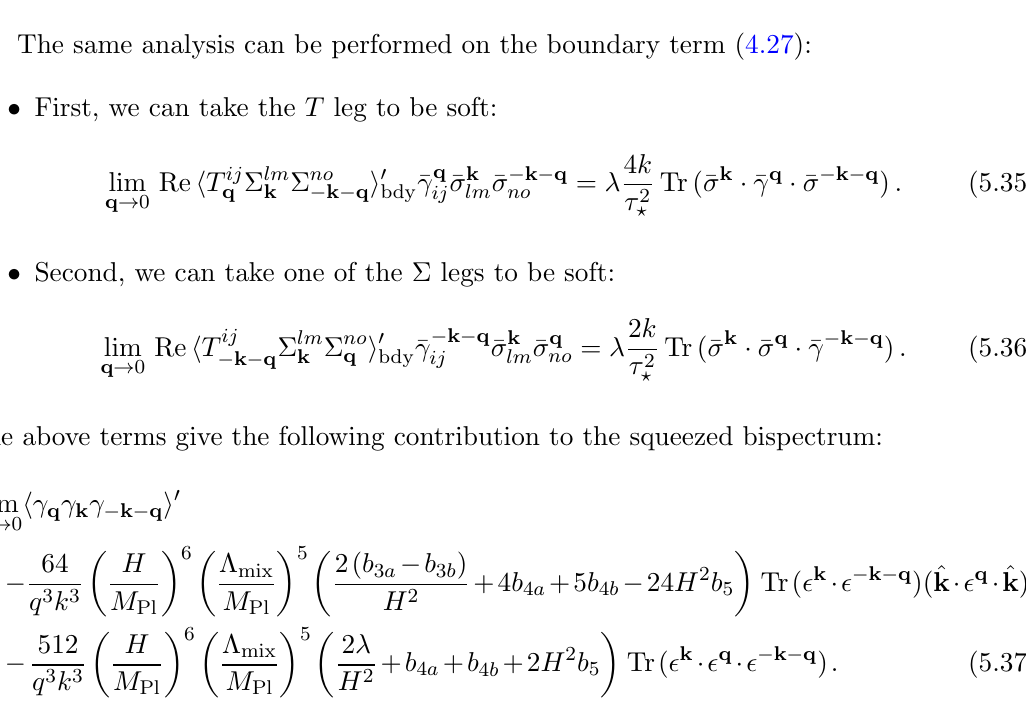
T 4 from gravitons and partially massless h i